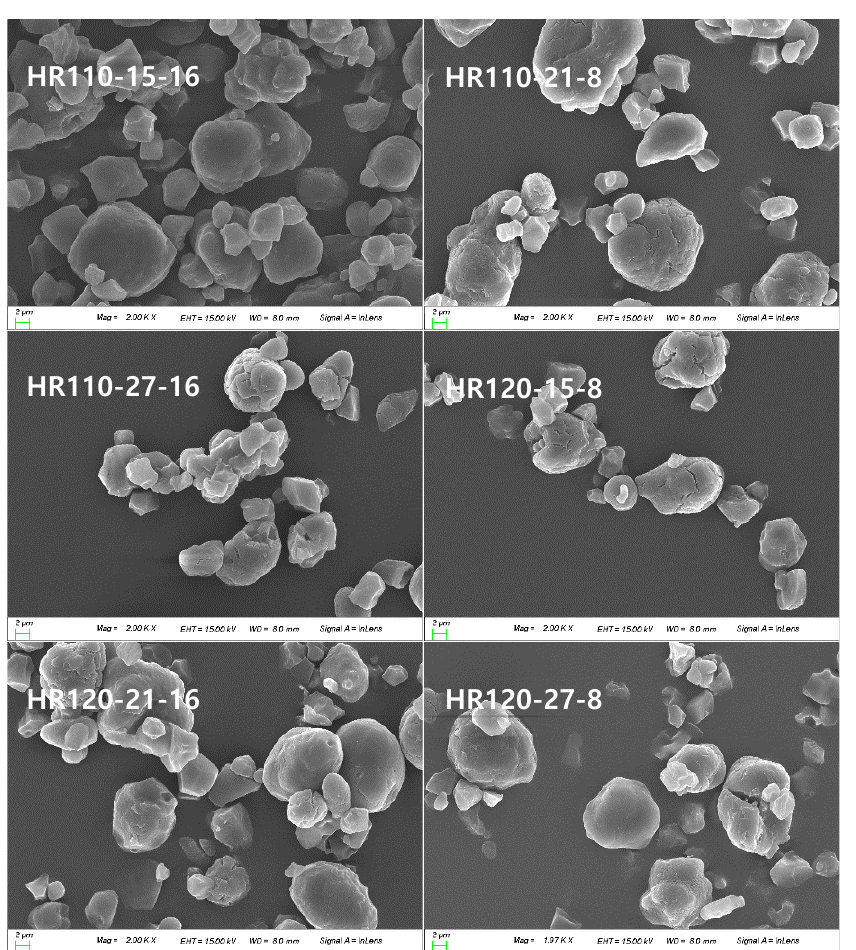
Figure 2. Scanning electron microphotographs of native and heat–moisture treated rice starches. NR: native rice starch, HR: heat–moisture treated rice starch, 100, 110 and 120: heat–moisture treatment temperature, 15, 21 and 27: moisture content, 8 and 16: heat–moisture treatment time.